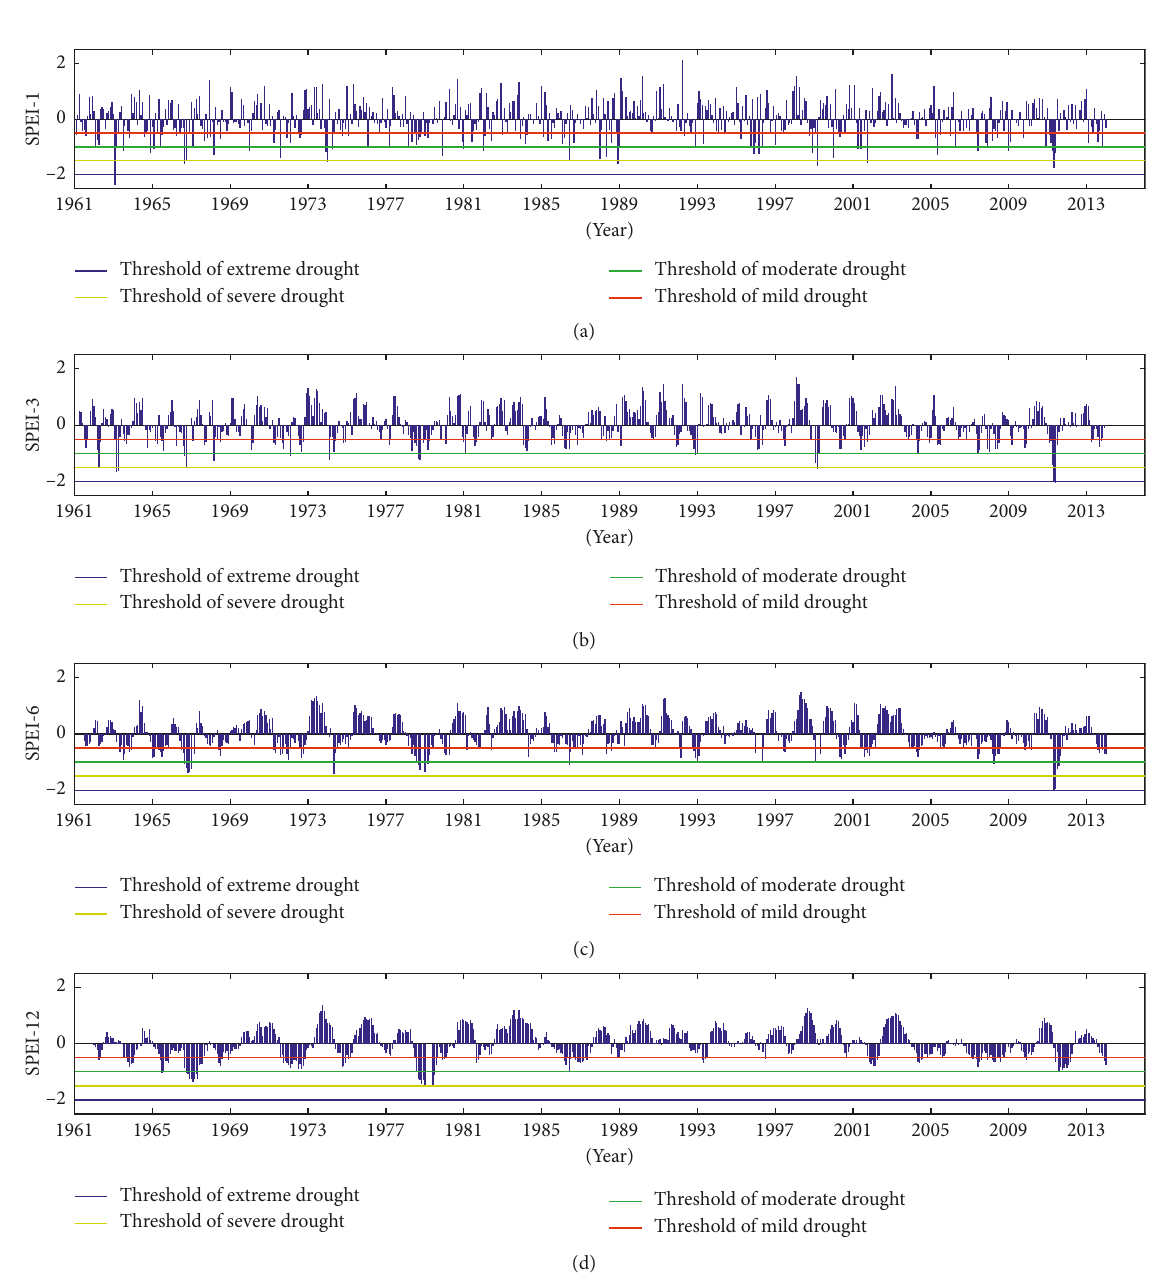
Figure 2: The temporal variability of the SPEI at (a) 1-month lag, (b) 3-month lag, (c) 6-month lag, and (d) 12-month